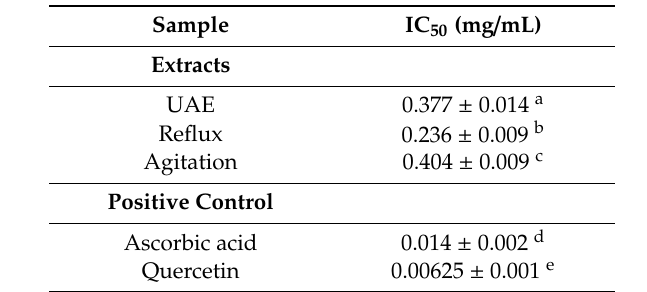
Figure 1. DPPH scavenging activity of UAE, reflux, and agitation C. papaya extracts. Results were expressed as the mean of three independent experiments. Table 3. IC 50 of 2, 2-diphenyl-1-picrylhydrazyl (DPPH) radical scavenging activity of C. papaya leaves